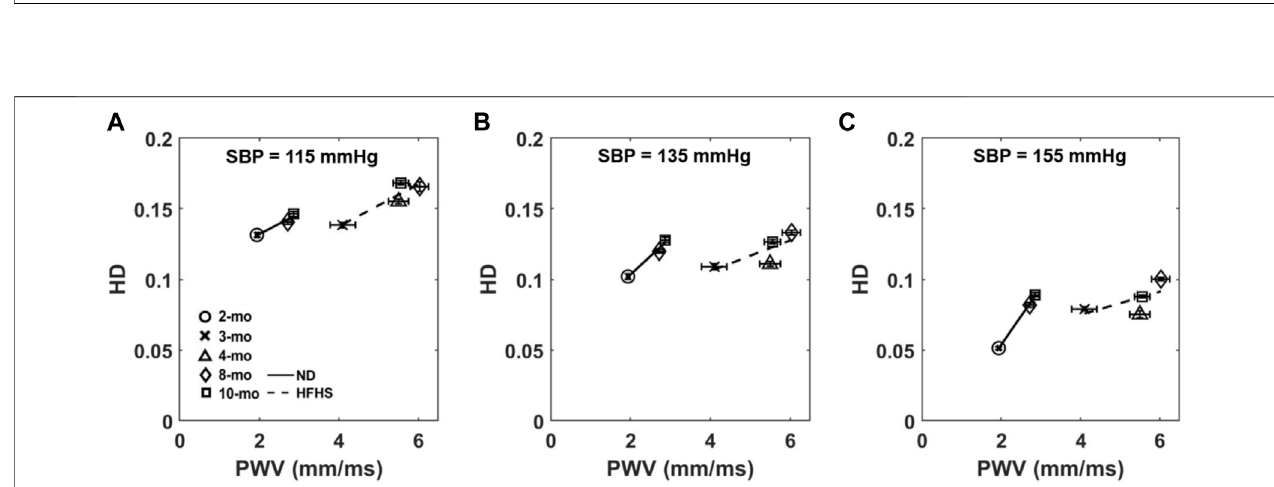
FIGURE 6 | Harmonic distortion from in vivo spectral analysis as function of tangent modulus measured by in vitro biomechanical testing for the 4-months (A) and 10-months mice (B) , normal (circles and solidline)and HFHSdiet (trianglesand dashed line). Linear regressions fromeach grouparealso displayed. (C) Average slopes of the harmonic distortion vs. tangent modulus linear fi tting for the age and diet